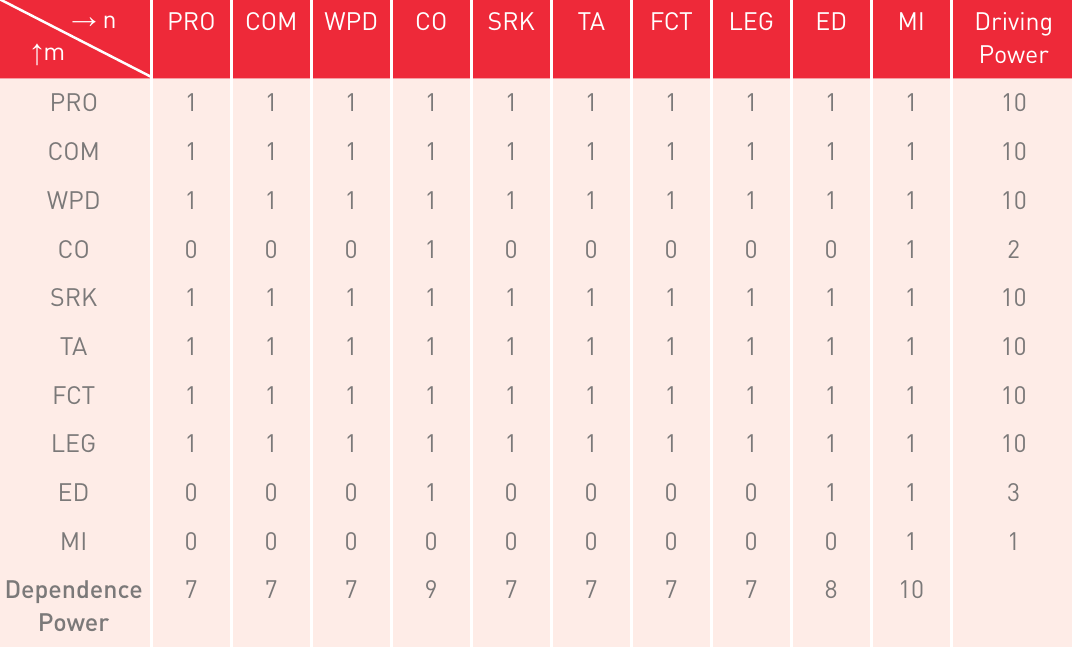
Final Reachability Matrix with Driving Powers and Dependence Powers- Barrier